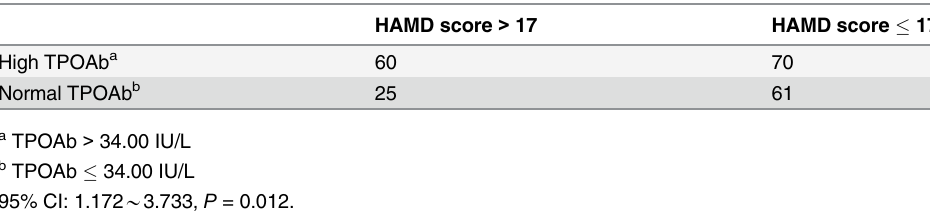
Table 4. Contingency table analysis of the correlation between TPOAb and HAMD score.